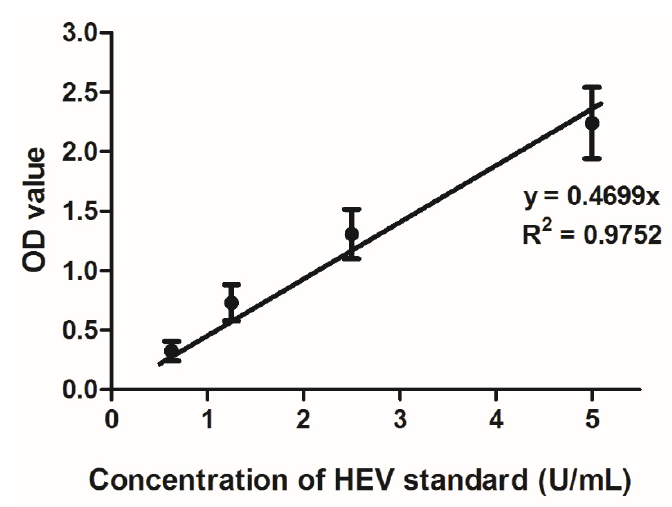
Figure 1. Standard curve of Wantai HEV IgG optical density values against the HEV WHO standard (U/mL). Four concentrations (0.625 – 5 U/mL) were tested with five replicates per concentration. Bars represent standard error of mean.